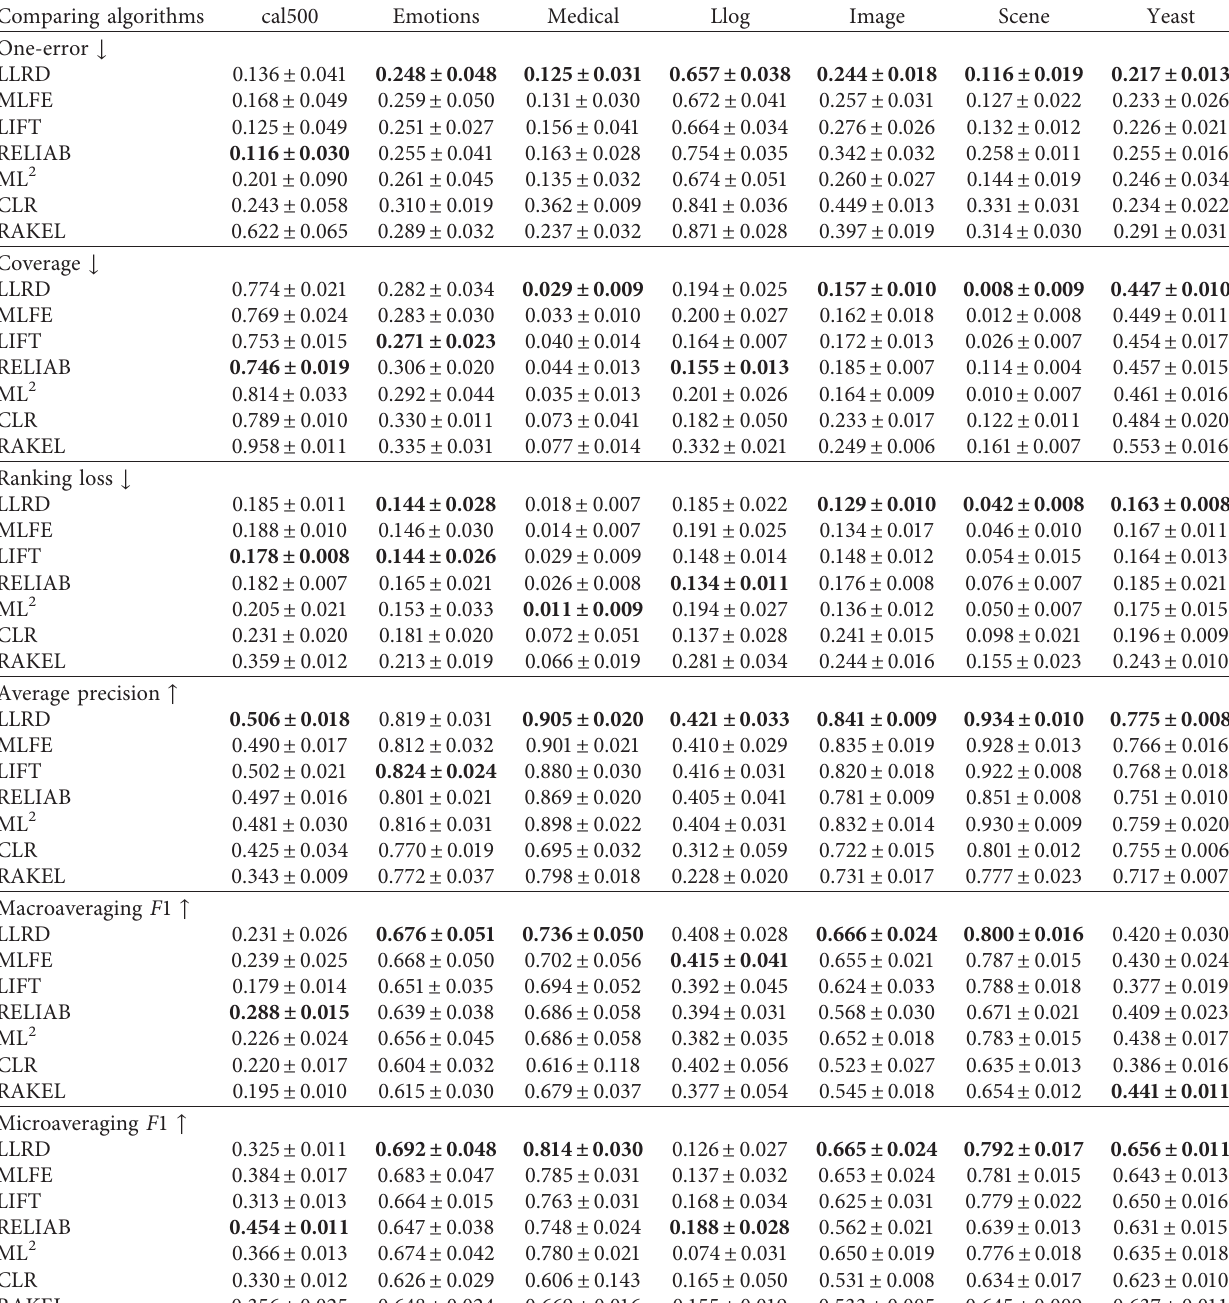
Table 2: Performance of each multilabel algorithm (mean ± std. deviation) on the regular-scale datasets. Comparing